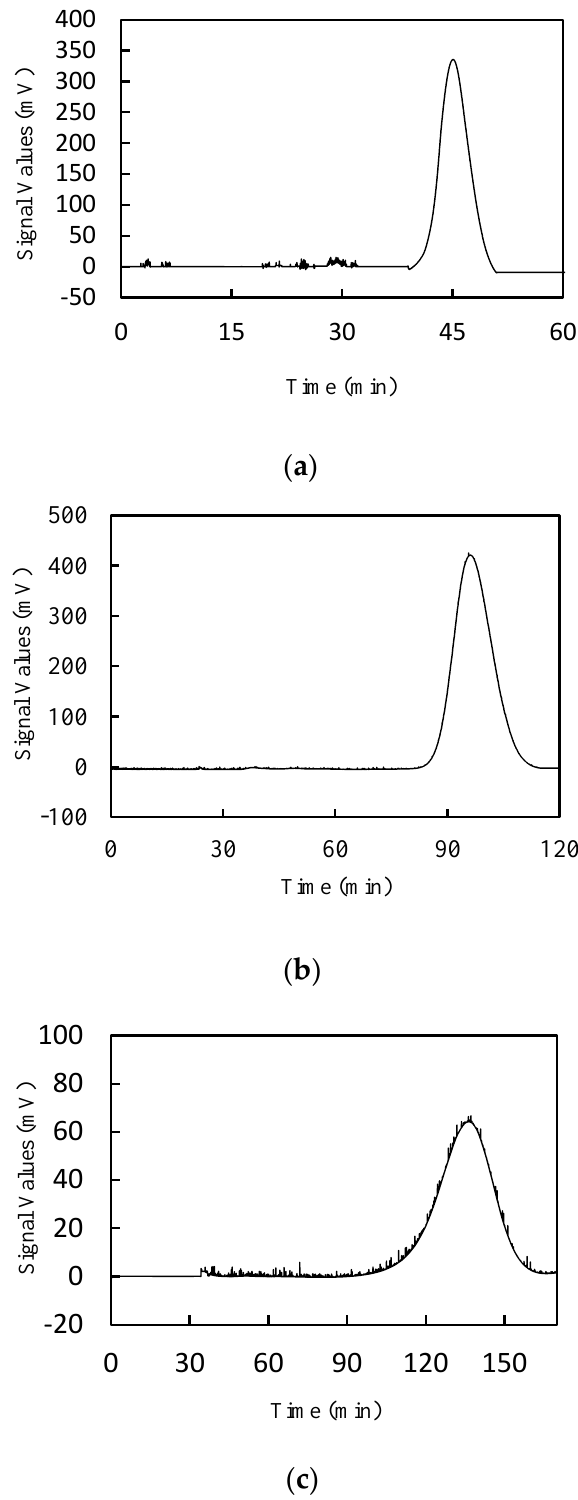
Figure 3. High-speed counter-current chromatography (HSCCC) chart of the rutin standard in different